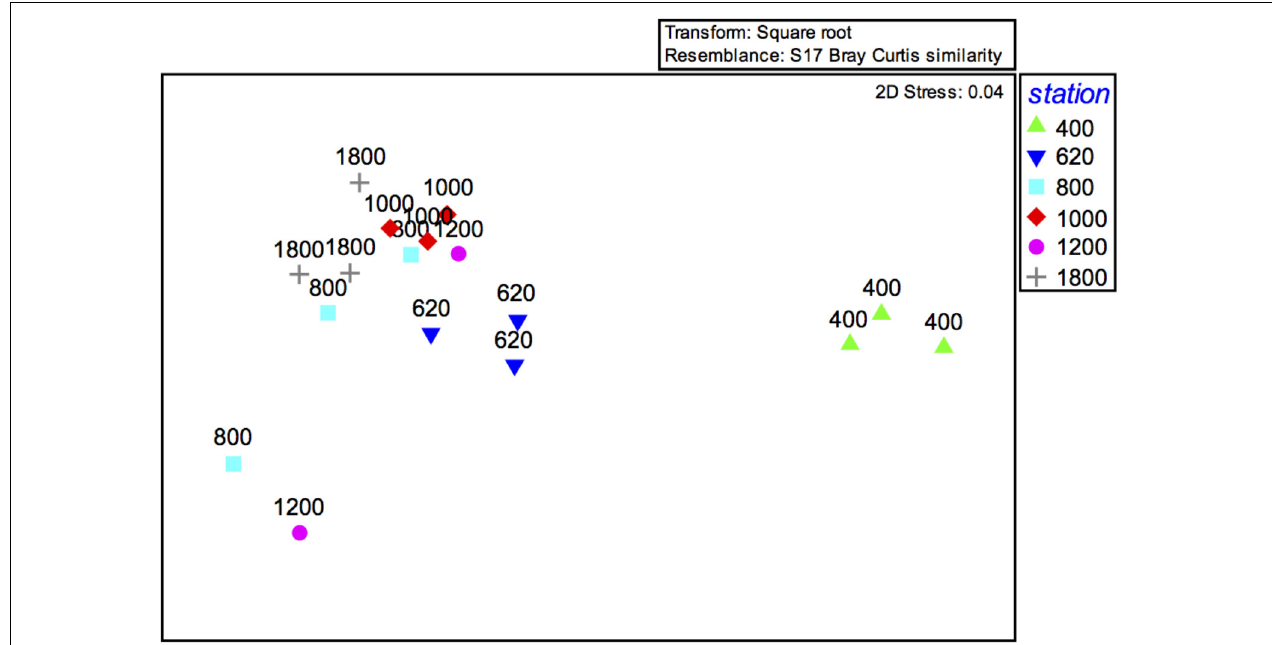
FIGURE 6 | MDS ordination plot of meiofaunal community structure (0–10 cm) along the depth transect off Costa Rica.